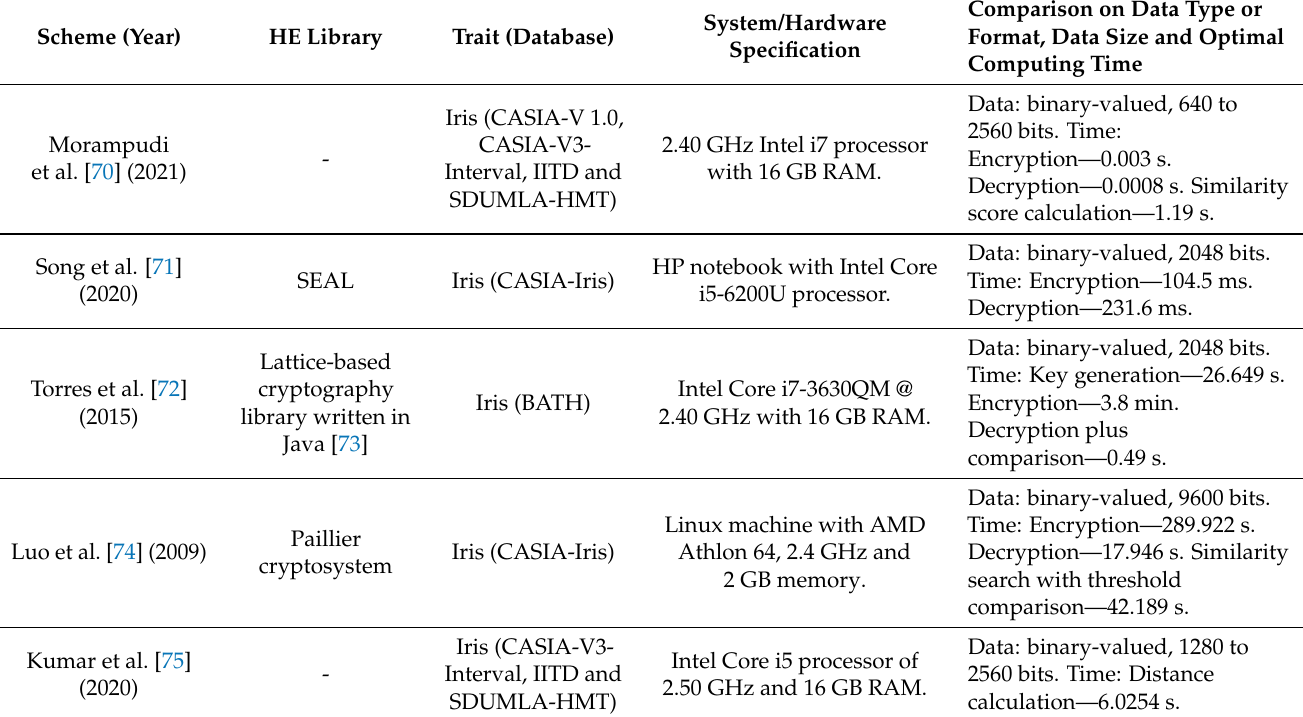
Table 3. Comparison of HE-based approaches to iris security in terms of computational